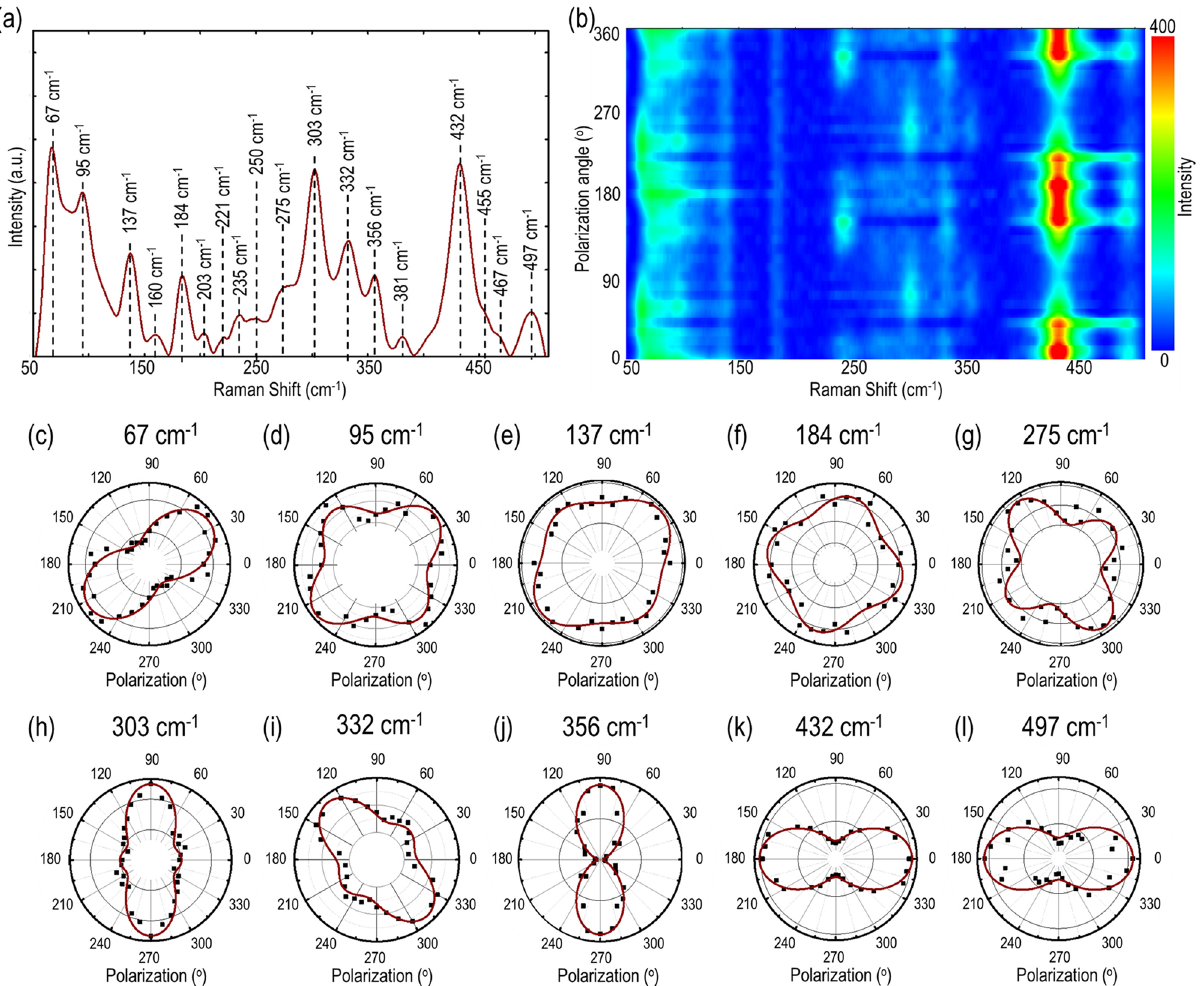
Figure 3. Evolution of angle-resolved Raman modes in gerstleyite crystal. ( a ) Recorded Raman spectra of the 88 nm-thick gerstleyite flake. The identified Raman modes are indicated with black dashed lines. ( b ) Color map of the recorded angle-resolved Raman spectra in parallel polarization configuration. ( c – l ) Polar plots of the Raman intensity variations of parallel polarization components for Raman modes at 67, 95, 137, 184, 275, 303, 332, 356, 432 and 497 cm −1 . Black squares indicate the measured data points, while brown solid lines show the corresponding theoretical